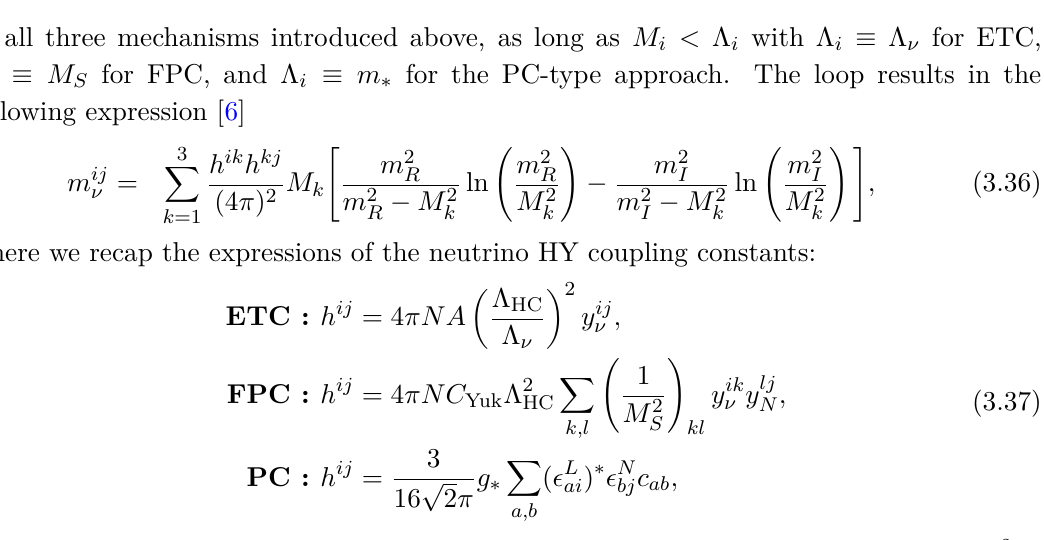
Figure 2 . One-loop Majorana neutrino mass for heavy right-handed neutrinos in the composite scenarios, with ETC and FPC